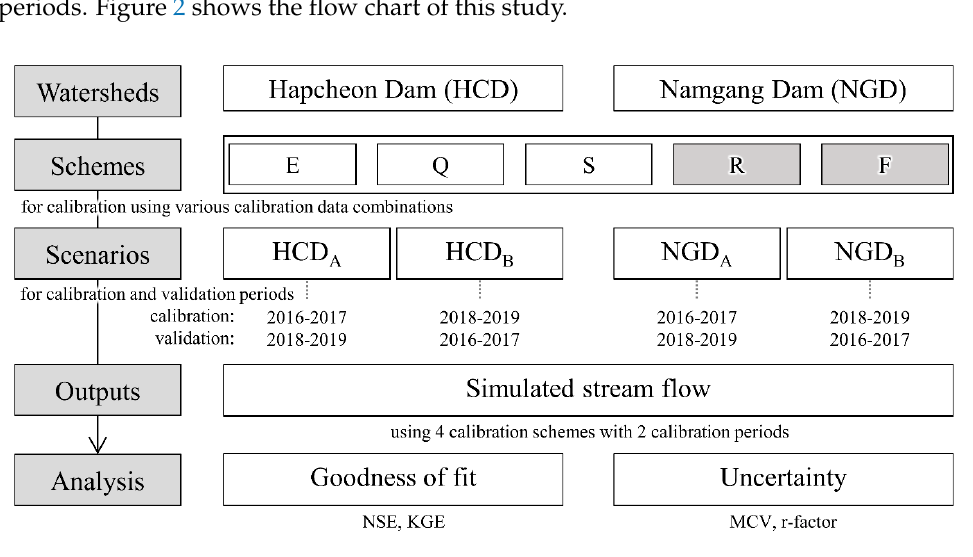
Figure 2. Schematic flow chart for this study.